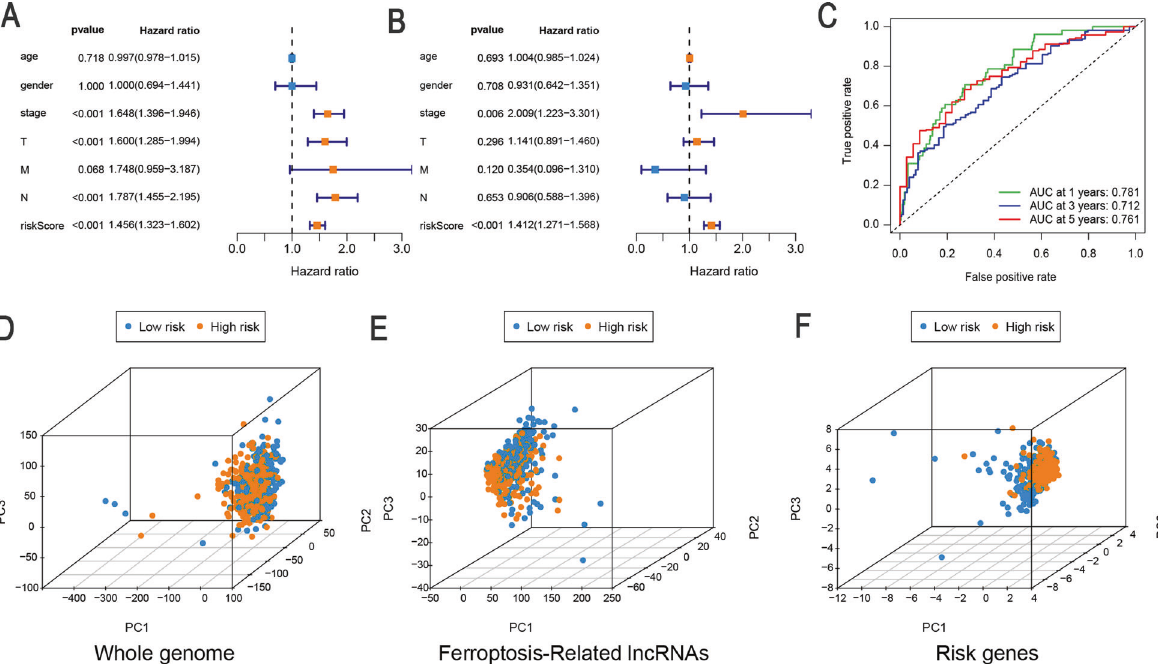
Fig. 4 FerRLSig is an independent prognostic factor for overall survival. Univariate ( A ) and multivariate ( B ) Cox regression analyses of associations between clinical parameters (including FerRLSig) and OS. C Time-dependent ROC curves of OS at 1, 3, and 5 years. Principal component analysis (PCA) of low-risk and high-risk groups based on the ( D ) whole-genome, ( E ) ferroptosis-related lncRNAs, and ( F ) the risk model including 10 ferroptosis-related lncRNAs; patients with high risk scores are indicated in orange, and those with high risk scores are indicated in blue. T, tumor stage; N stage, lymph node metastasis stage; M stage, distant metastasis stage.